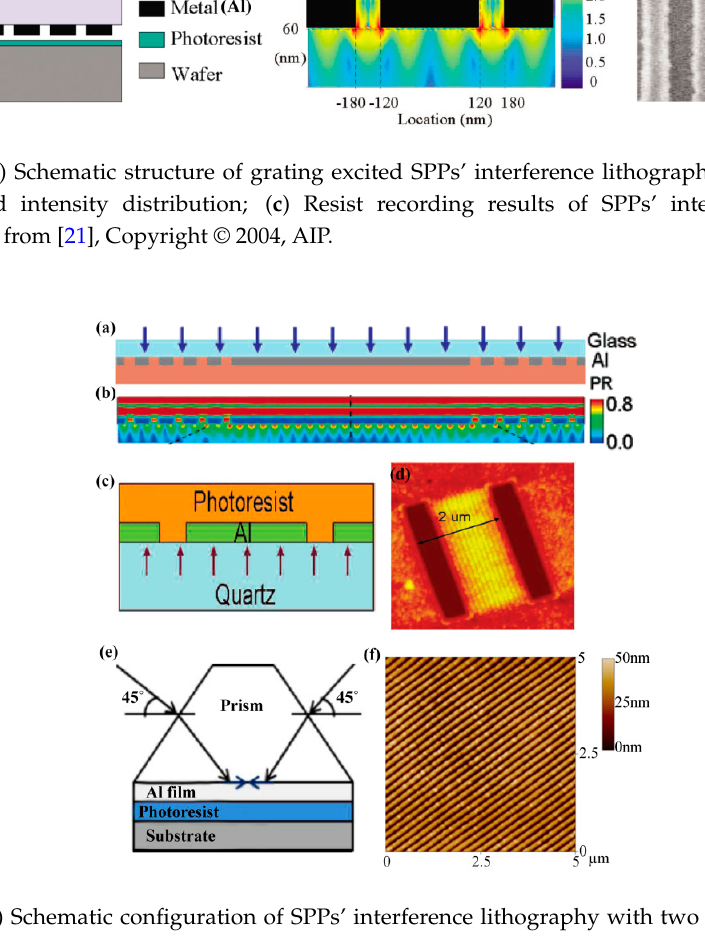
Figure 8. ( a ) Schematic configuration of SPPs’ interference lithography with two parallel gratings; ( b ) Cross sections of electrical field | E | distribution in (a); ( c ) Schematic experimental configuration of SPPs interference lithography; ( d ) Exposure pattern of structure (c); ( e ) SPPs’ interference through prism excitation; ( f ) Atomic force microscopy (AFM) image of one-dimensional interference patterns by prism. Reproduced from: (a,b), [49], Copyright © 2005, ACS; (c,d), [50], Copyright © 2009, ACS; (e,f) [52], Copyright © 2010, OAS.